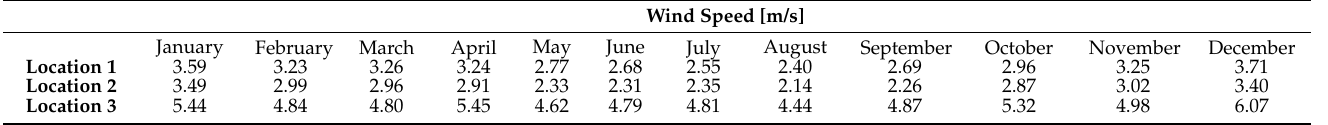
Table A1. Distribution of mean monthly wind speeds from 2014 to 2018 at the three locations.